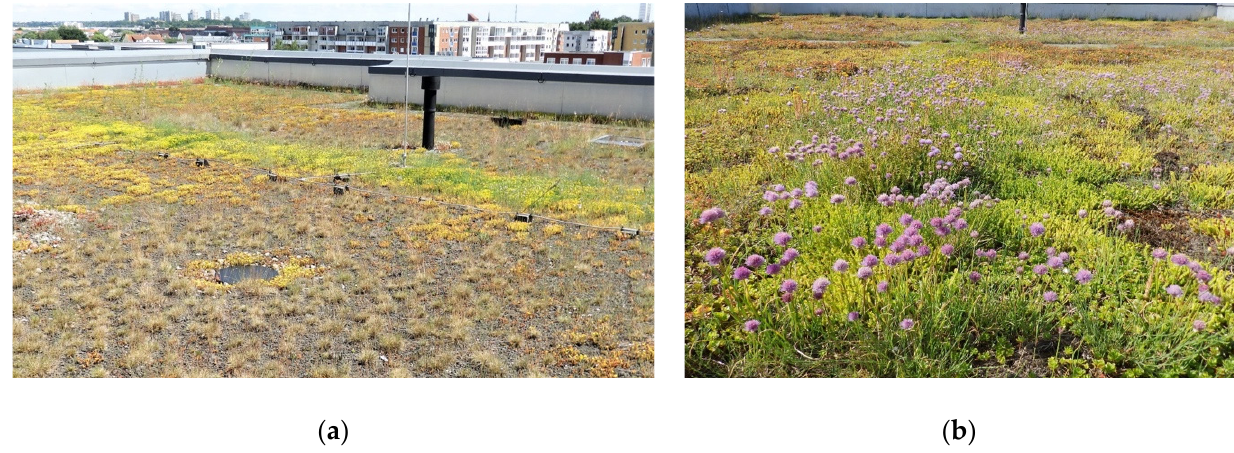
Figure 3. ( a ) View to the eastern roof section, left: growing media Op, right: Ul-media. The line demarcating fertilizer application in June 2020 can be clearly seen, about 4 weeks after the application. ( b ) Western roof area, the fertilized area on the Op media is in the foreground while the Ulo section is in the background. The more intense blooming can be seen on 20 June 2020, four weeks after the fertilizer application.